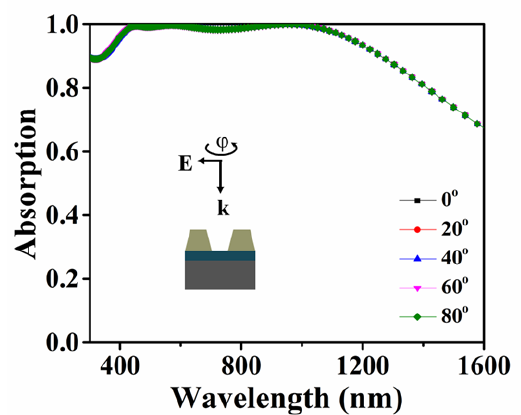
Figure 7. Absorption curves for different polarization angles under normal incidence.